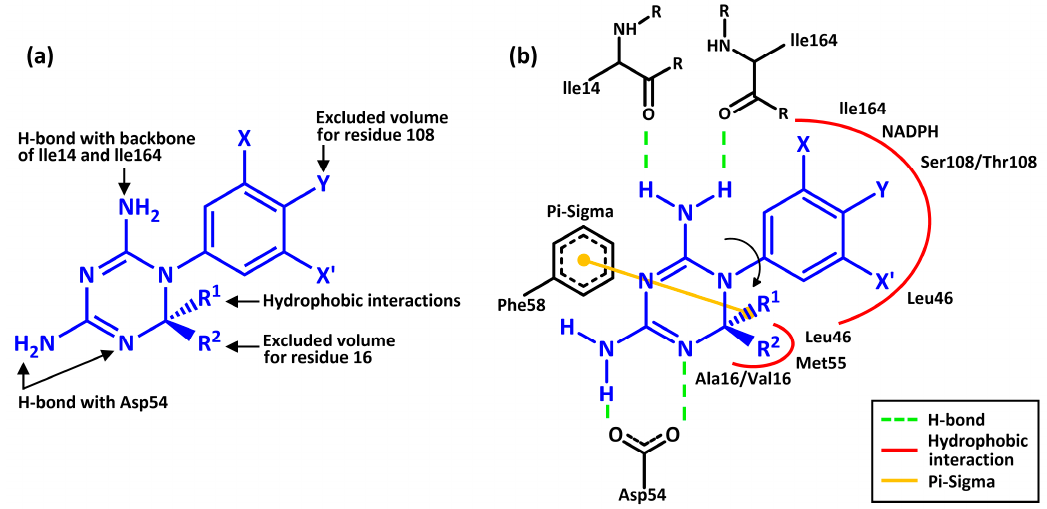
Figure 2. Simplified view of ( a ) essential binding characteristics of a good inhibitor of pf DHFR; ( b ) binding interactions of Cyc derivatives inside the wild-type and mutant pf DHFR binding pockets. Blue indicates the general structure of Cyc derivatives.